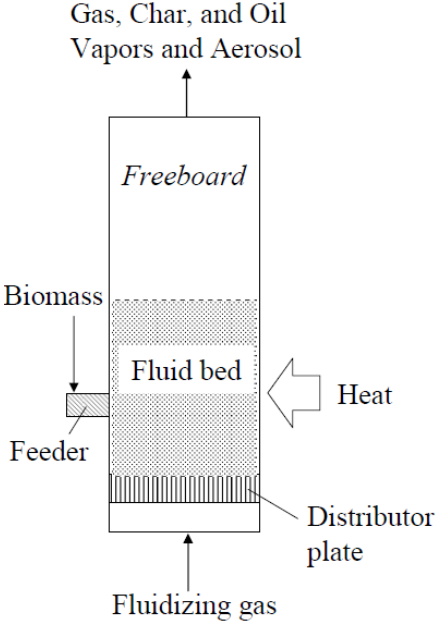
Figure 4. Bubbling fluidized-bed reactor